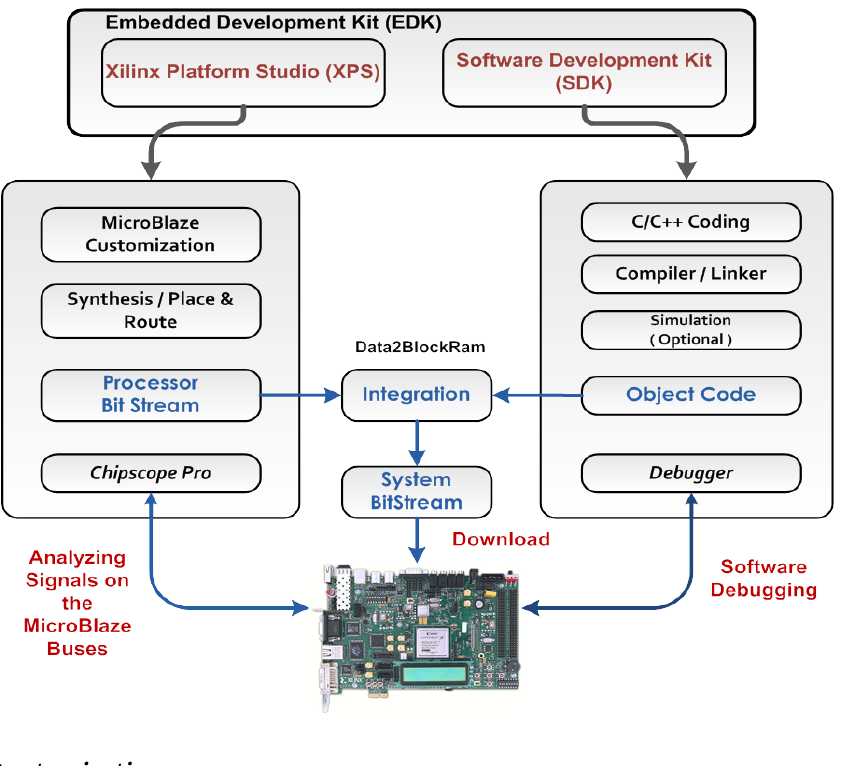
Figure 6. Hardware Customization and Software Development Flows Using Xilinx’s